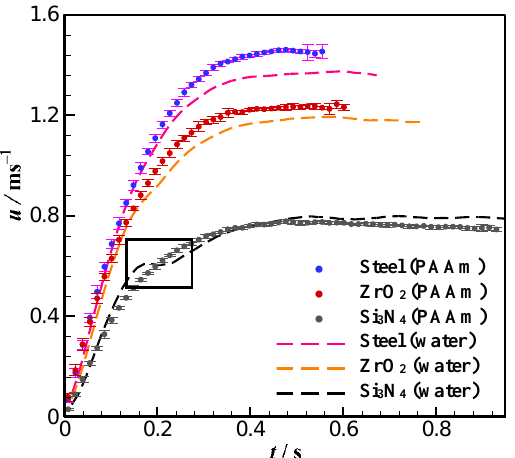
Figure 11. Variation in vertical velocity u of a single particle with different densities in PAAm solution and water.